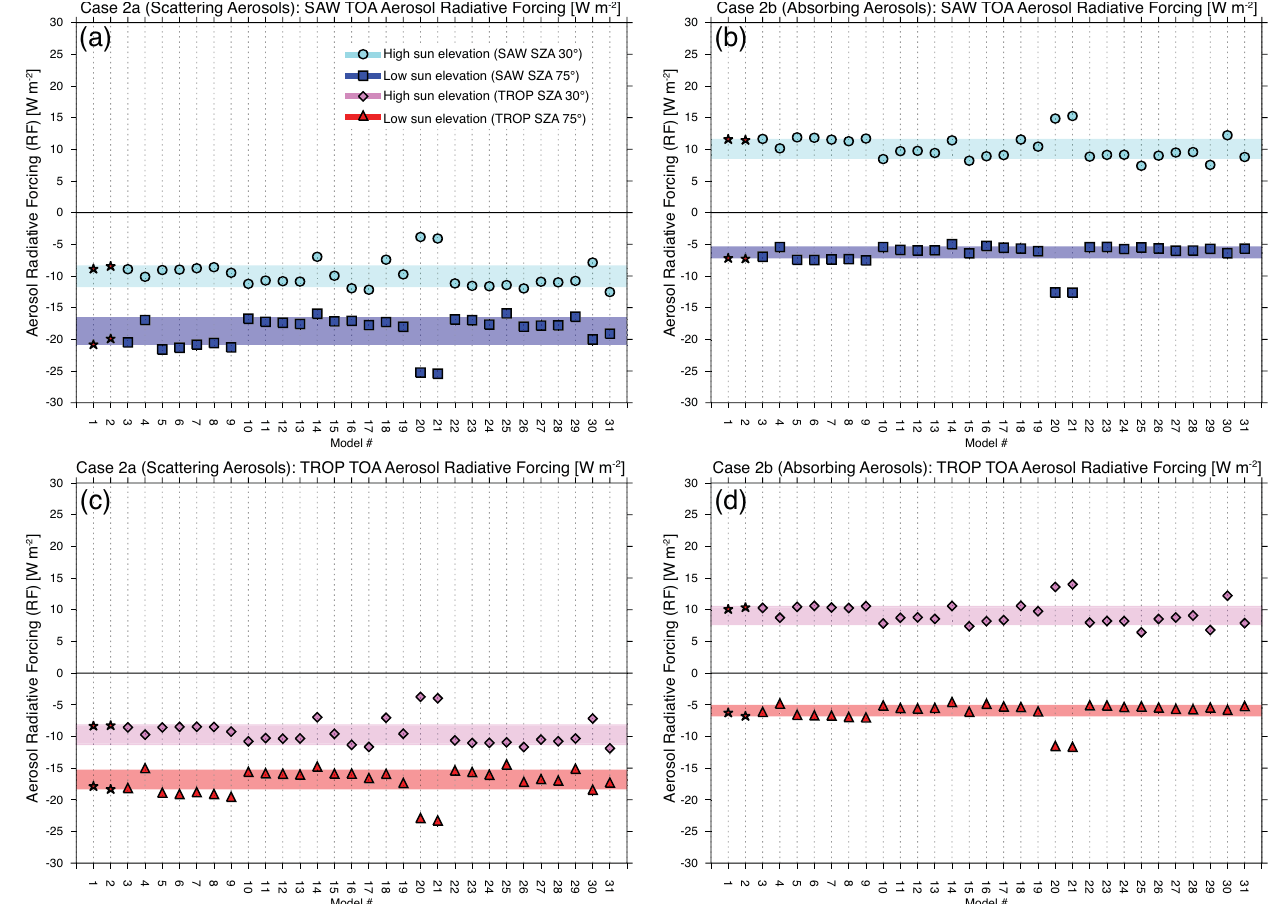
Fig. 4. Summary of results for top of the atmosphere aerosol radiative forcing (TOA RF) in Wm − 2 : (a) Case 2a (Scattering Aerosols) SAW, (b ) Case 2b (Absorbing Aerosols) SAW, (c) Case 2a (Scattering Aerosols) TROP, and (d) Case 2b (Absorbing Aerosols) TROP. Line-by-line results (stars) and non-LBL results (non-stars) are given as a function of Model # (Table 1). Shading represents the greater of ± 1 standard deviation from the LBL or non-LBL mean (excluding Models 20–21). RF was calculated from Eq. (2) using normalized flux results that were scaled by the broadband downwards fluxes given in Fig.